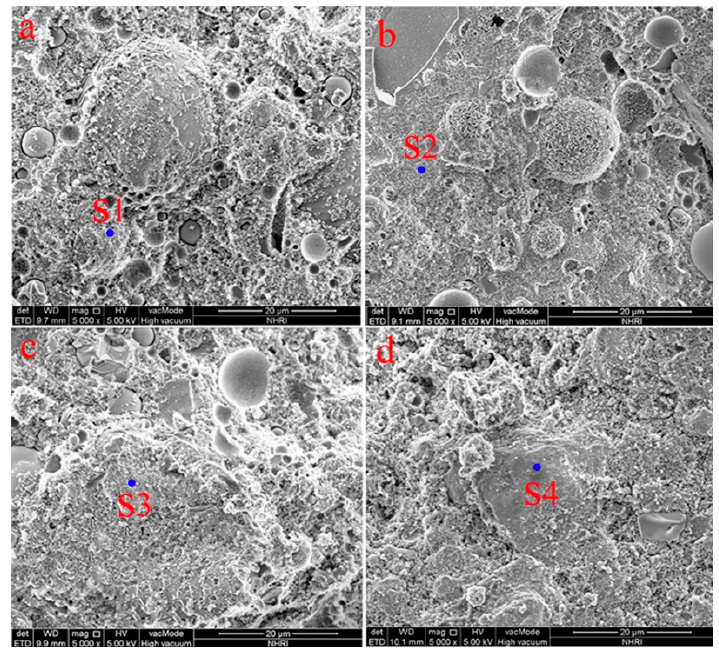
Figure 4. SEM Images of FAGC: ( a ) CAC-0; ( b ) CAC-2.5%; ( c ) CAC-5%; ( d ) CAC-7.5%. Table 4. Results of EDS of FAGC (atom percent %).